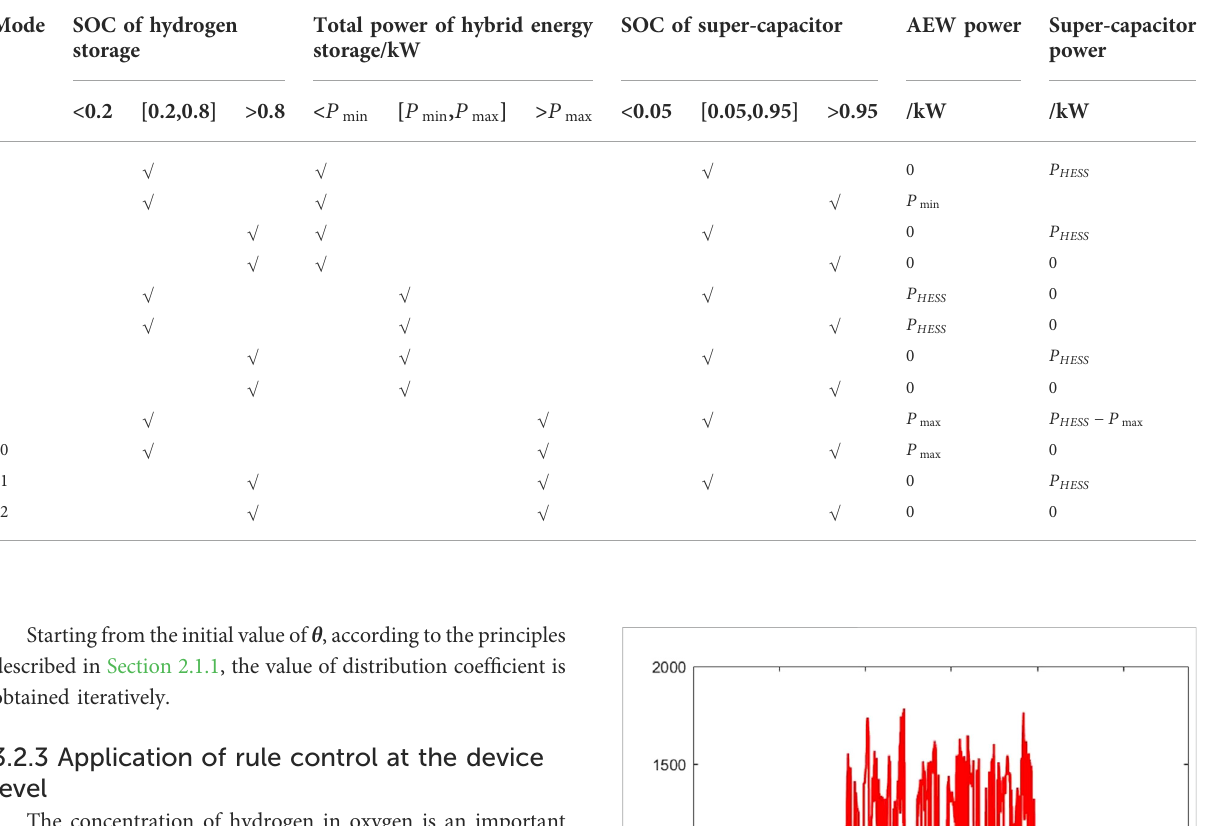
TABLE 2 Power allocation strategy when P HESS ( t ) > 0.